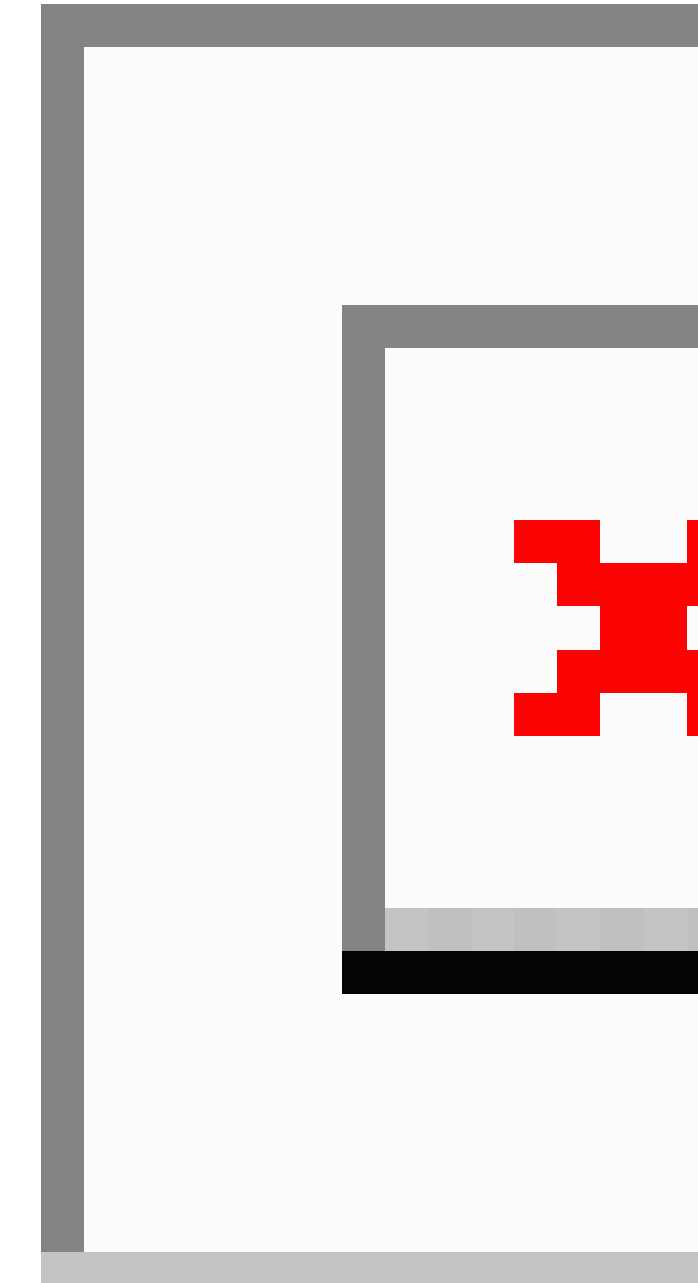
Figure 2. Twitter users providing location indicators in the US time zones.